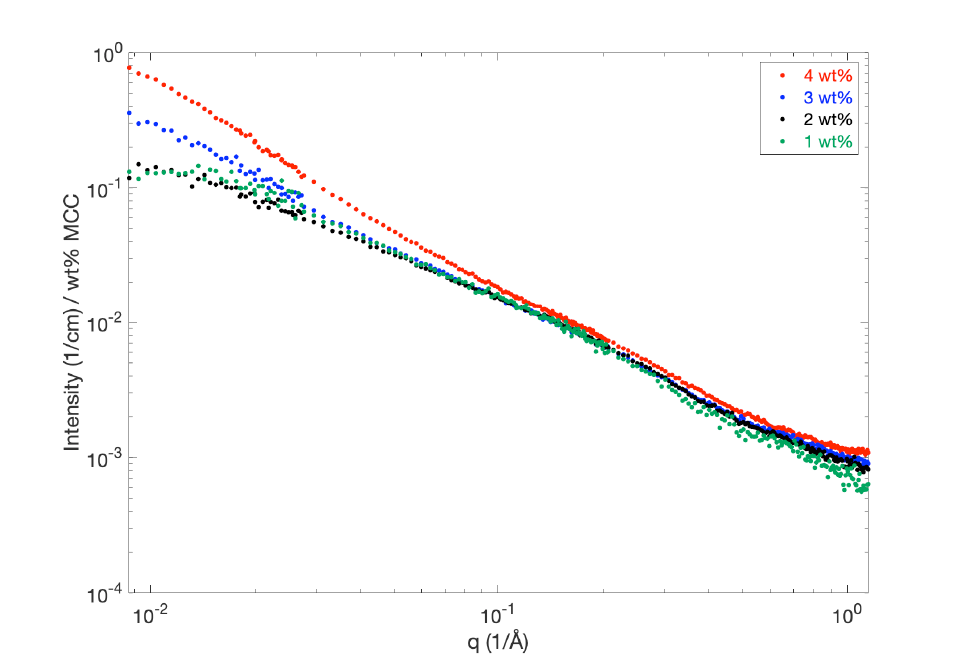
Figure 2. SAXS curves of microcrystalline cellulose (MCC) dissolved in 8 wt % (2 M) NaOH for MCC concentrations of 1, 2, 3 and 4 wt % MCC. The scattered intensity was scaled with the respective MCC weight fractions to facilitate comparisons of the different scattering